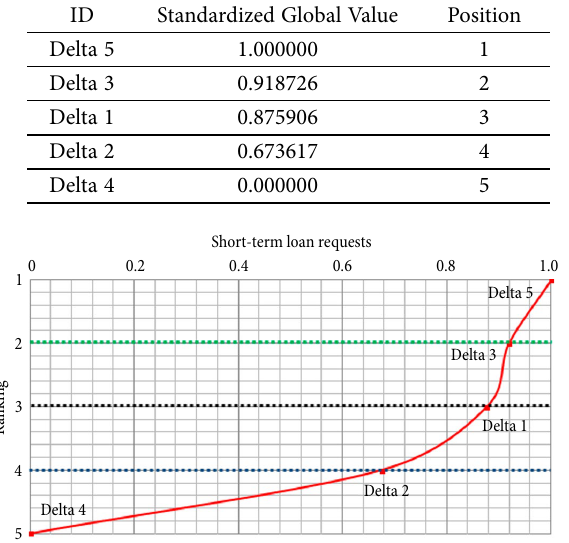
Fig. 4. Standardized global value and respective position